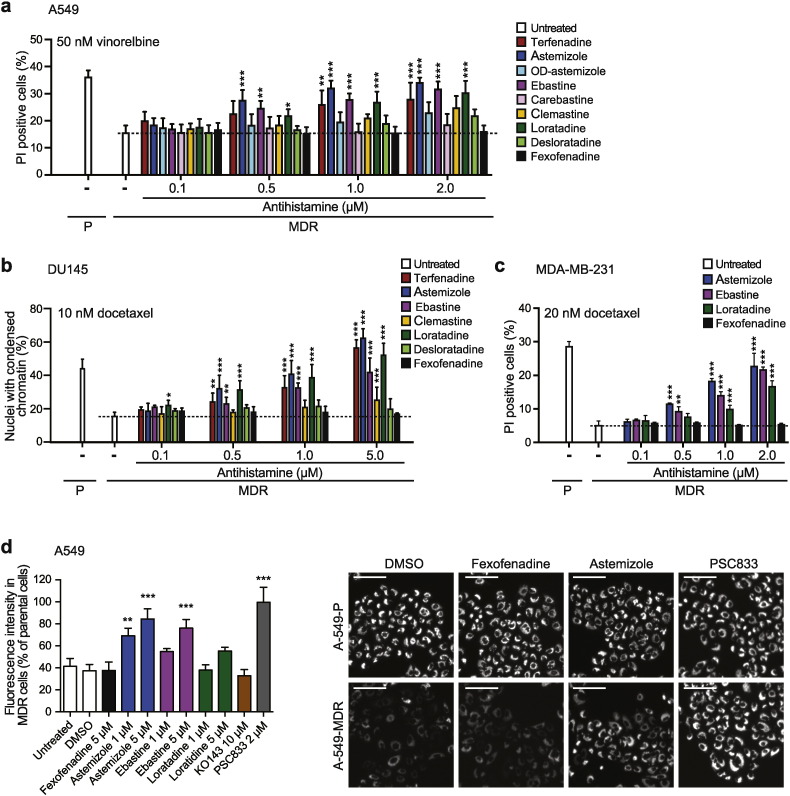
The ability of CAD antihistamines to re-sensitize MDR cancer cells to chemotherapy.(a–c) Death of parental (P) and multidrug resistant (MDR) A549 (a), DU145 (b) and MDA-MB-231 (c) cells (PI exclusion) induced by a 48 h treatment with indicated chemotherapeutics alone (white bars) or in combination with indicated concentrations of antihistamines. See also Supplemental Fig. S2c-e.(d) Fluorescence intensity in A549-P and A549-MDR cells treated with Rhodamine123 for 1 h prior to 2 h treatment with indicated concentrations of antihistamines or MDR inhibitors KO143 (ABCG2) or PSC833 (MDR1) was assessed with the Celígo® Imaging Cytometer (left). Representative images of selected conditions are shown (right). Scale bars, 100 μm. See also Supplemental Fig. S3.Error bars, SD for three independent, triplicate experiments.*p < 0.05, **p < 0.01, ***p < 0.001 when comparing MDR cells treated with and without antihistamines (a–c) or when comparing drug-treated and untreated cells (d) in a one-way (d) or two-way (a–c) ANOVA followed by Dunnett's multiple comparisons tests.